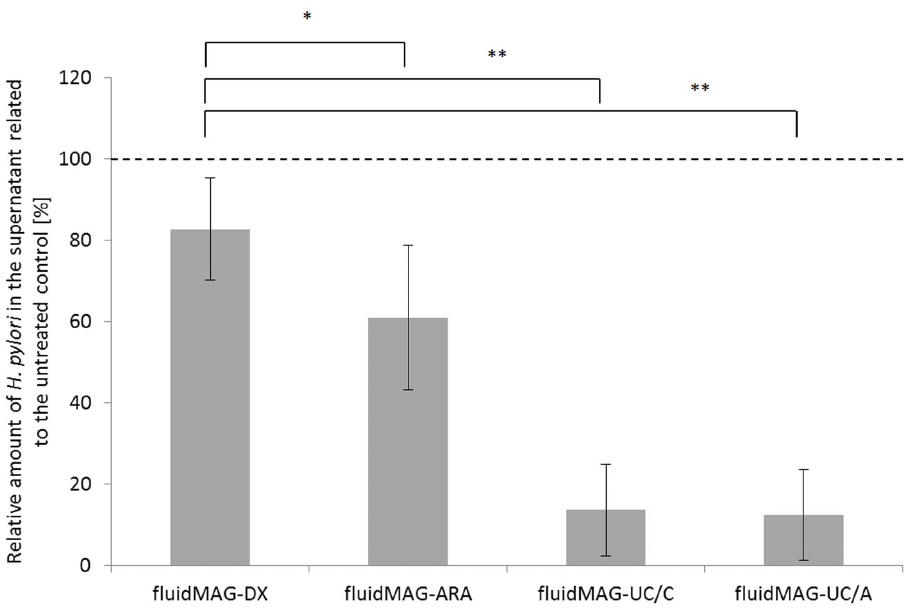
Figure 6. Adhesion assay with MNPs. Amount of bacteria in the untreated control was calculated as 100% and is indicated as broken line. Results of the samples incubated with MNPs are related to the values of the untreated control. Samples are named according to the type of MNPs added. Results are mean values with 6 SD from six independent experiments with *: p , 0.05 and **: p , 0.01. Significance values refer to the comparison with the fluidMAG-DX H values, as indicated by the brackets.